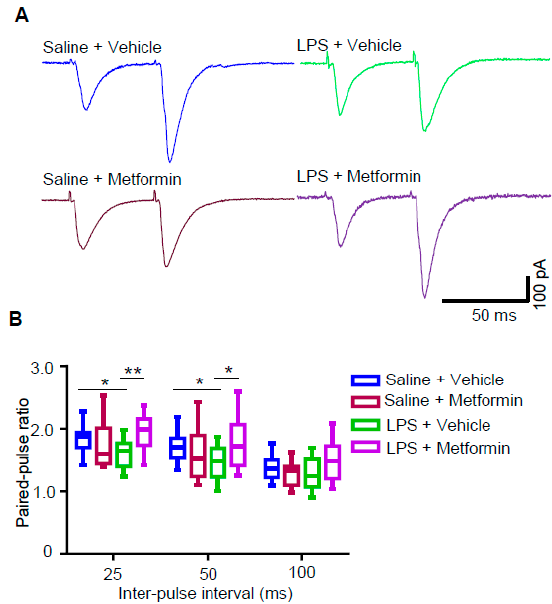
Figure 5. Metformin reduces presynaptic glutamate release in LPS-induced depression mouse model. ( A ) Representative traces of paired-pulse ratio (PPR) in CA1 pyramidal neurons from mice of four different groups: saline + vehicle (blue), saline + metformin (brown), LPS + vehicle (green) and LPS + metformin (purple). ( B ) PPRs plotted against interstimulus intervals (n = 13–14 neurons from 3 mice for each group; two-way ANOVA, * p < 0.05, ** p < 0.005).